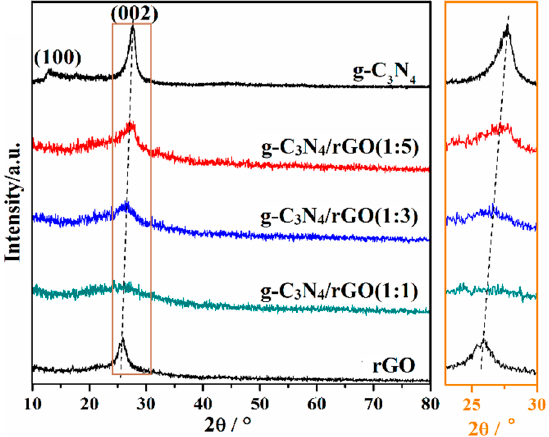
Figure 2. X-Ray Diffraction (XRD) diffraction pattern of g-C 3 N 4 , rGO, g-C 3 N 4 /rGO nanocomposite.